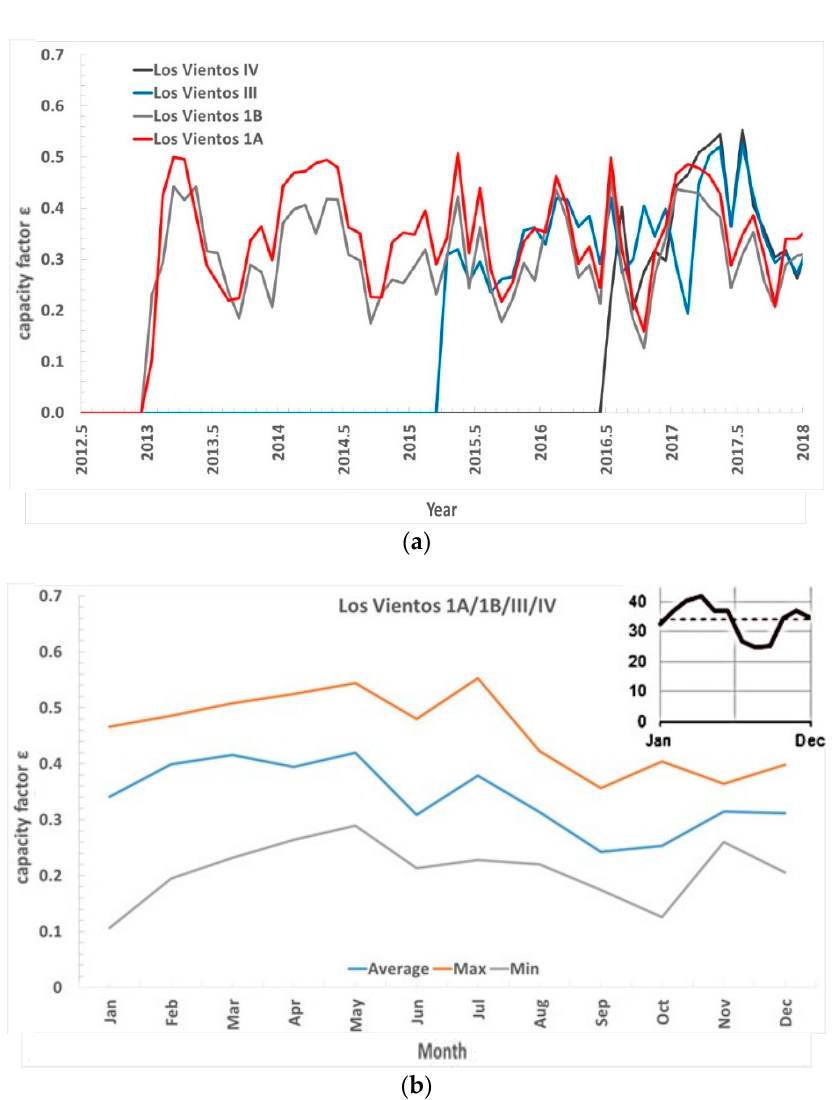
Figure 4. Los Vientos (LV) wind energy complex units. ( a ) ε m since the start of the operation of the individual WEF. ( b ) Maximum, minimum, and average ε m of all the WEFs in the complex since the start of the operation of every WEF. The result compared with the reference seasonal variability for the Lower Plains according to [54], image reproduced modified after [54]. X-axis time, years ( a ) or months ( b ); Y-axis capacity factor ε (generating power vs. registered power) ε , Table 2. Los Vientos (LV) wind energy complex (TX).